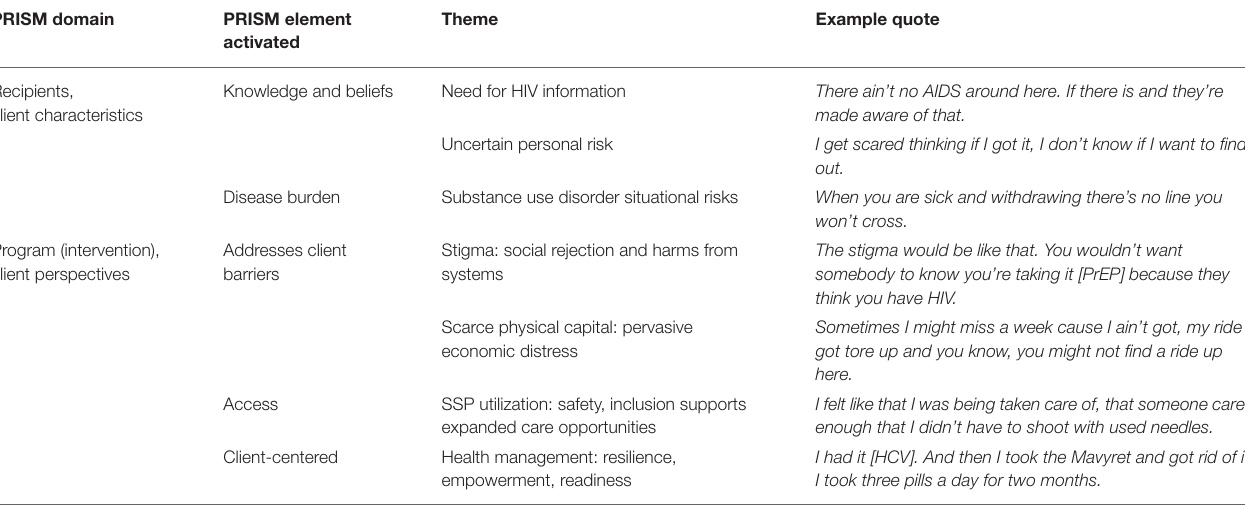
TABLE 2 | Primary Themes for HIV Prevention and PrEP Uptake among Rural PWID Mapped to PRISM Domains. PRISM